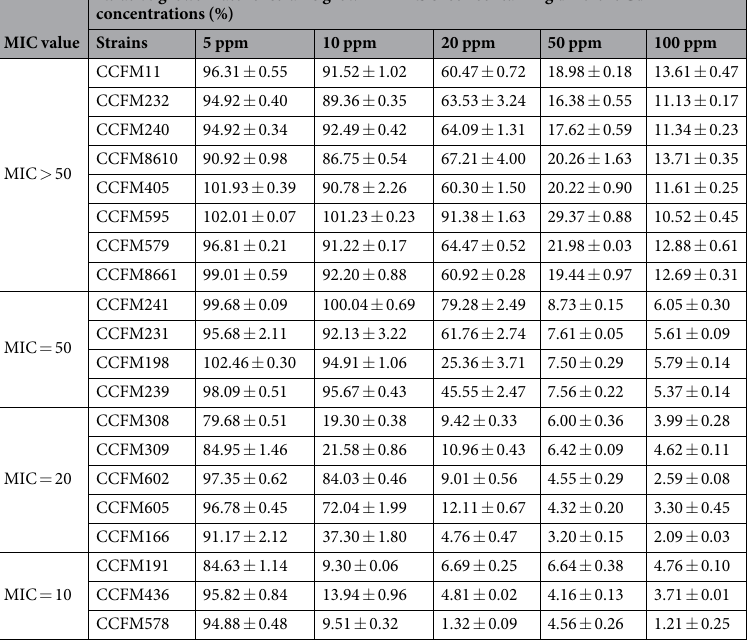
Table 1. Relative growth rate of L . plantarum strains grown in MRS broth containing different Cd concentrations. a Relative growth rate of each strain was expressed as percentage of OD 600 value of control culture (without Cd exposure) which was assigned a value of 100%. Data are expressed as mean ± SEM of three independent experiments per assay.